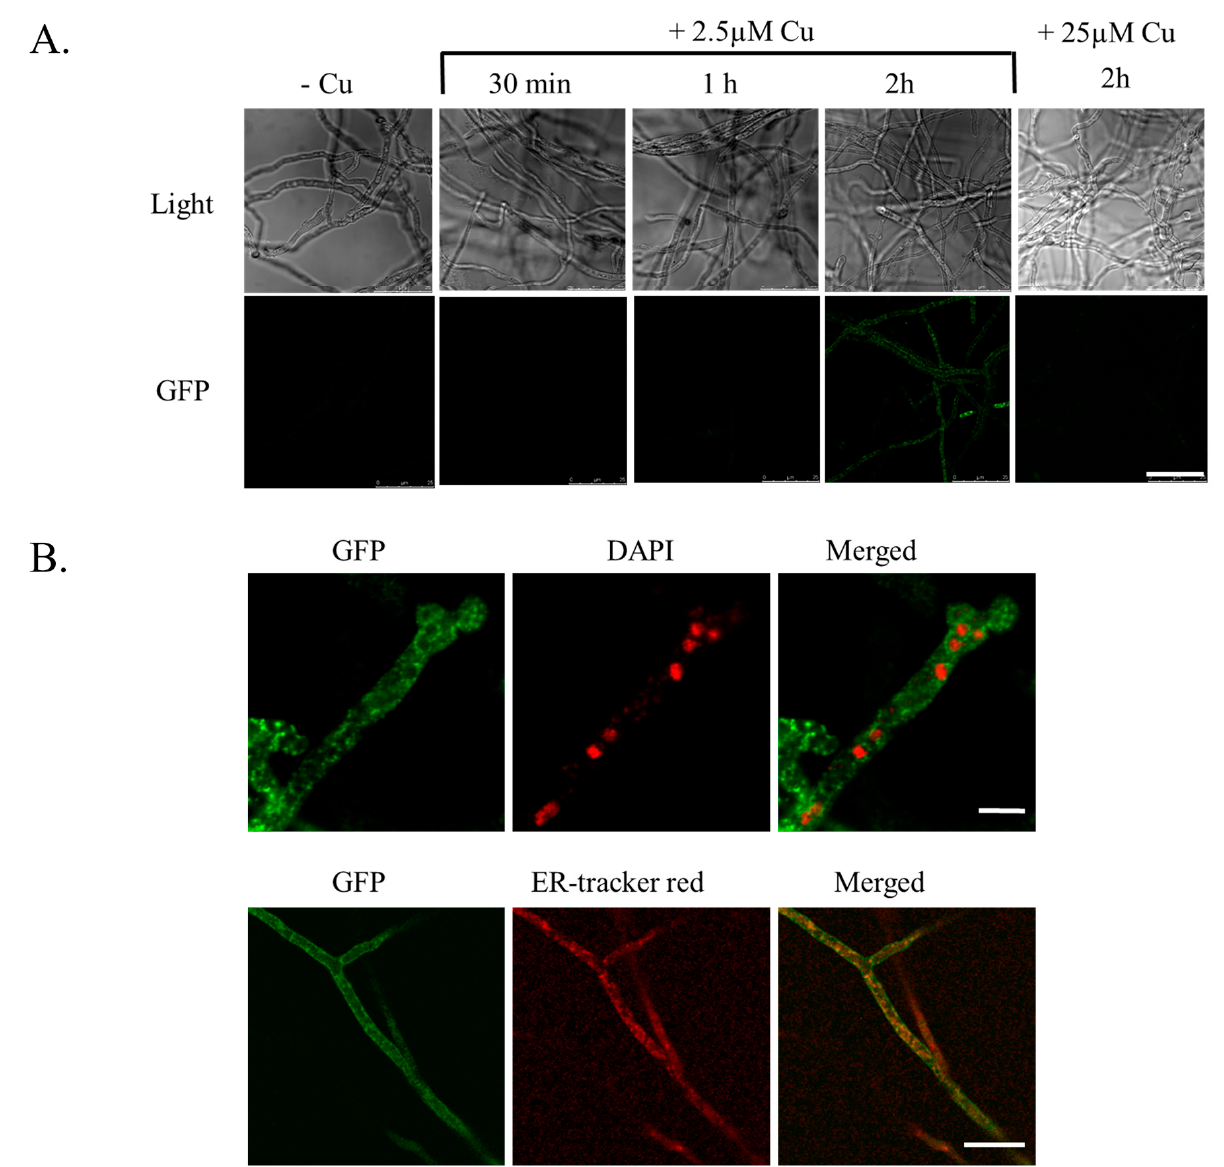
Figure 3. Cu-inducible expression of A. fumigatus CrpA-GFP and localization to the ER. CrpA_cont conidia were grown in liquid MMVUU for 16 h at 37 ◦ C and then shifted to Cu. ( A ) CrpA-GFP expression after a shift to 2.5 µ M or 25 µ M Cu for up to 2 h. Size-bar = 25 µ m. ( B ) CrpA-GFP localization after a shift to 2.5 µ M for 2 h and nuclear staining with DAPI (top panel) (size-bar = 2.5 µ m) or ER-Tracker Red (lower panel) (size-bar = 10 µ m). Fluorescence images were acquired using confocal